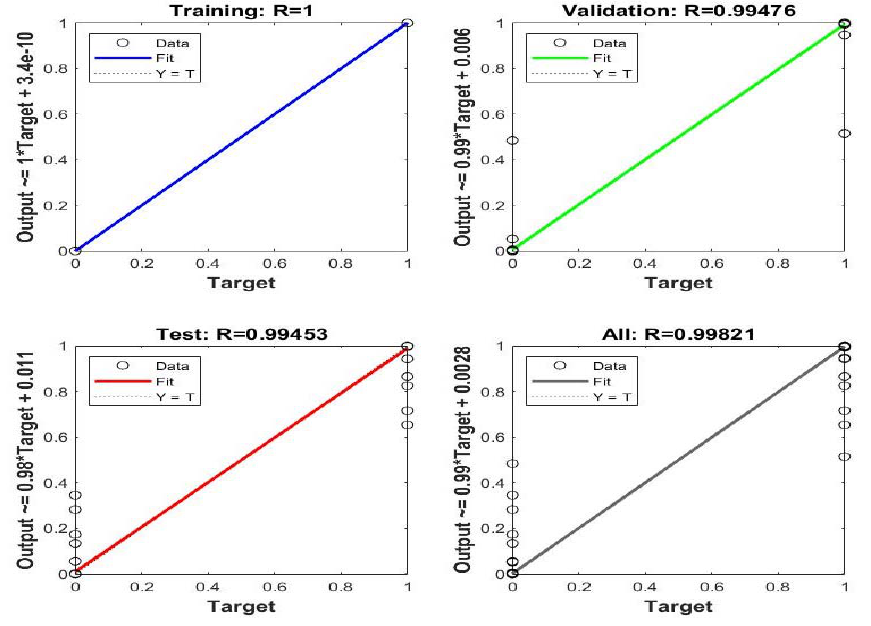
Figure 14. Regression plot of ASD dataset by FFNN.